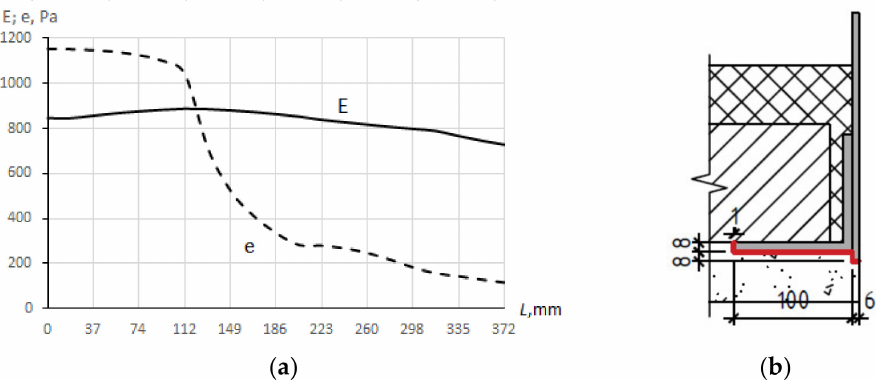
Figure 10. Graphs of changes in partial pressure of water vapor e and partial pressure of saturated water vapor E in the area of metal structures that do not come into contact with the attic air ( a ); the condensation area along the perimeter of the section of the bottom chord of the truss (units: mm) ( b ). As seen from the graphs in Figure 10a, water vapor condenses and corrosion of metal structures is possible. The length of the condensation area along the perimeter of the